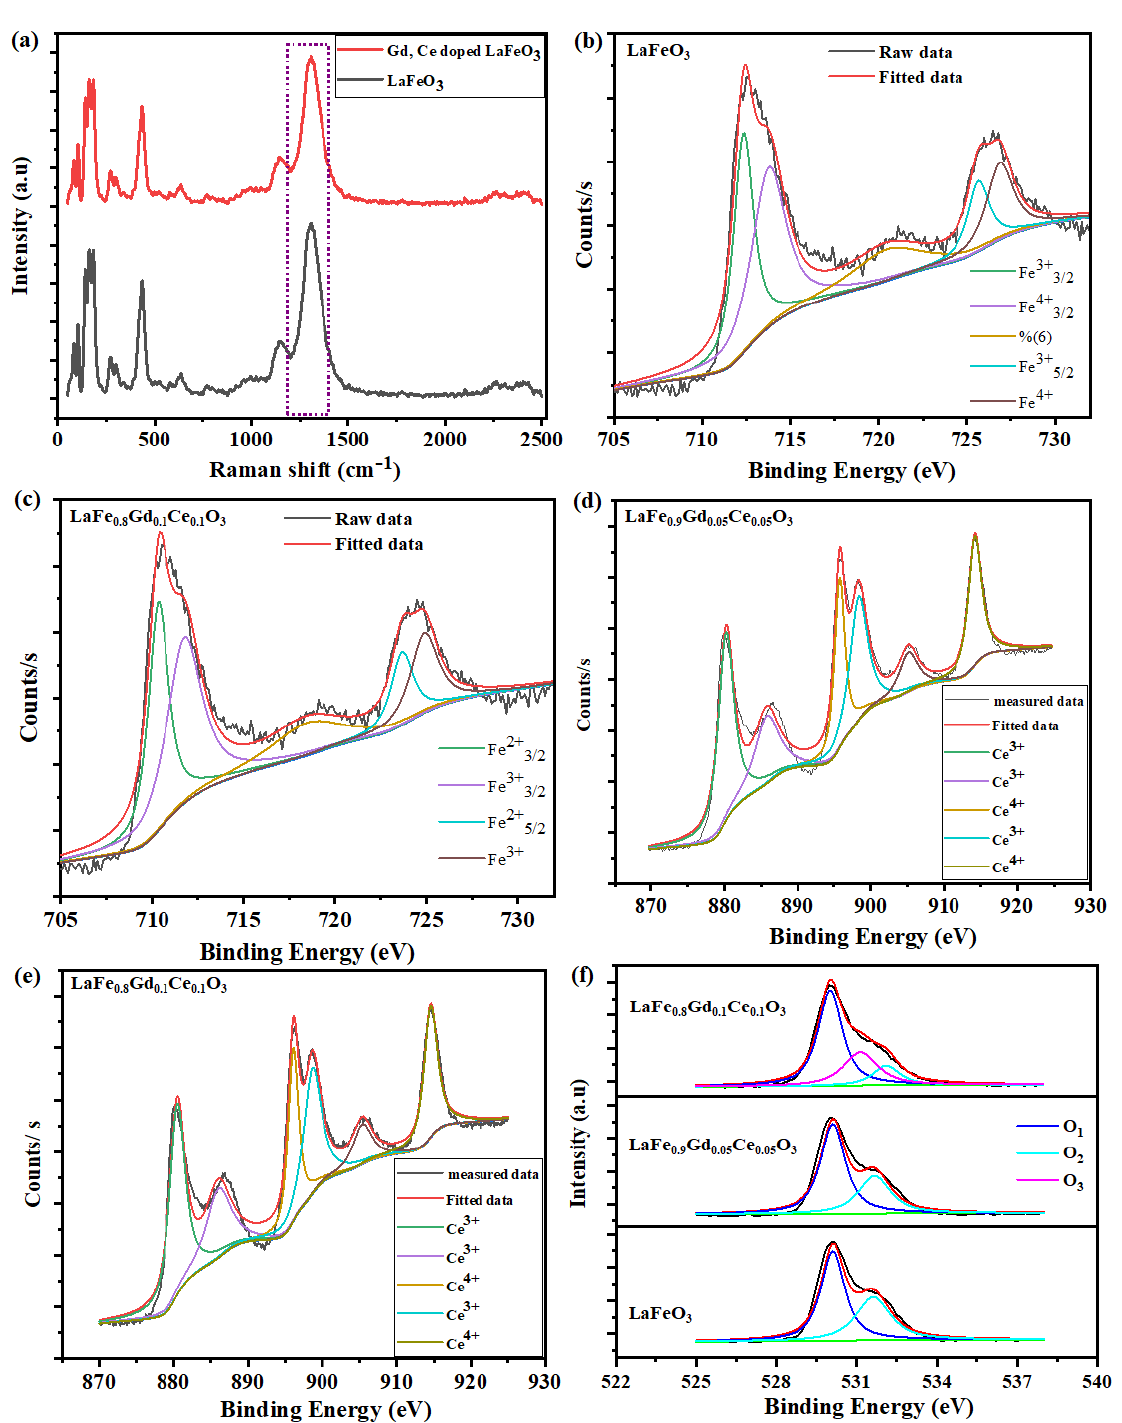
Figure 7. ( a ) Raman spectra of LaFeO 3 and LaFe 0.8 Gd 0.1 Ce 0.1 O 3- δ ( b , c ) Fe-2p X-ray photoelectron spectra of LaFeO 3- δ individual powders and after doping of Gd and Ce to form LaFe 0.8 Gd 0.1 Ce 0.1 O 3- δ . ( d , e ) Ce-3d, XPS spectra of LaFe 0.9 Gd 0.05 Ce 0.05 O 3- δ and LaFe 0.8 Gd 0.01 Ce 0.1 O 3- δ sample and ( f ) O1s spectra, respectively.